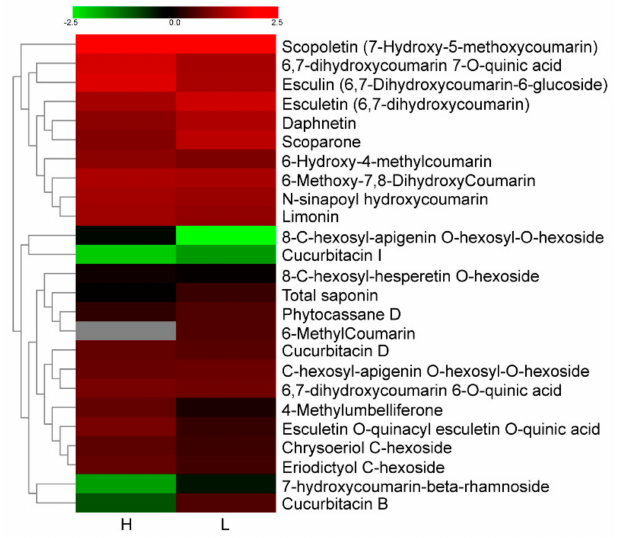
Figure 4. Cluster diagram of mevalonate pathway metabolic components and total saponins in high and low DNA methylation sample groups. The ordinate represents metabolite components, and the abscissa represents di ff erent samples. Red represents a relative increase in metabolites, and green represents a decrease in relative